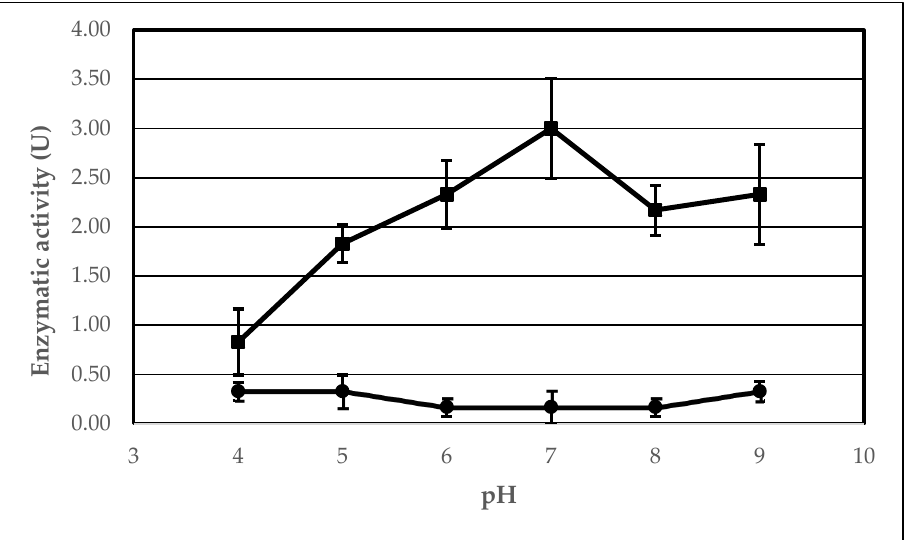
Figure 5. Effect of pH on AA-ANL activity in free form (circles) and immobilized onto IB-150A (squares). Reaction mixture: free AA-ANL (5.0 ± 0.2 mg) or AA-ANL immobilized onto IB-150A beads, phosphate buffer (100 mM, pH in the range of 4–9), and an emulsion containing equal volumes of peanut oil and gum arabic suspension. The mixture was incubated for 30 min. The error bars represent the standard deviations of the mean.